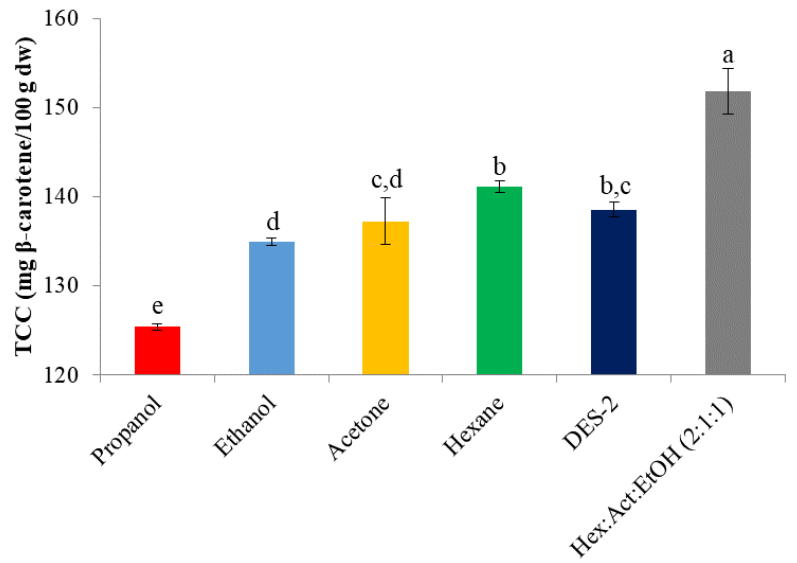
Figure 5. Total carotenoid content (TCC, mg β -carotene/100 g dw) of the extracts from APW using different solvents; Standard deviation is presented with error bars and means with different superscript letters are significantly ( p < 0.05) different.